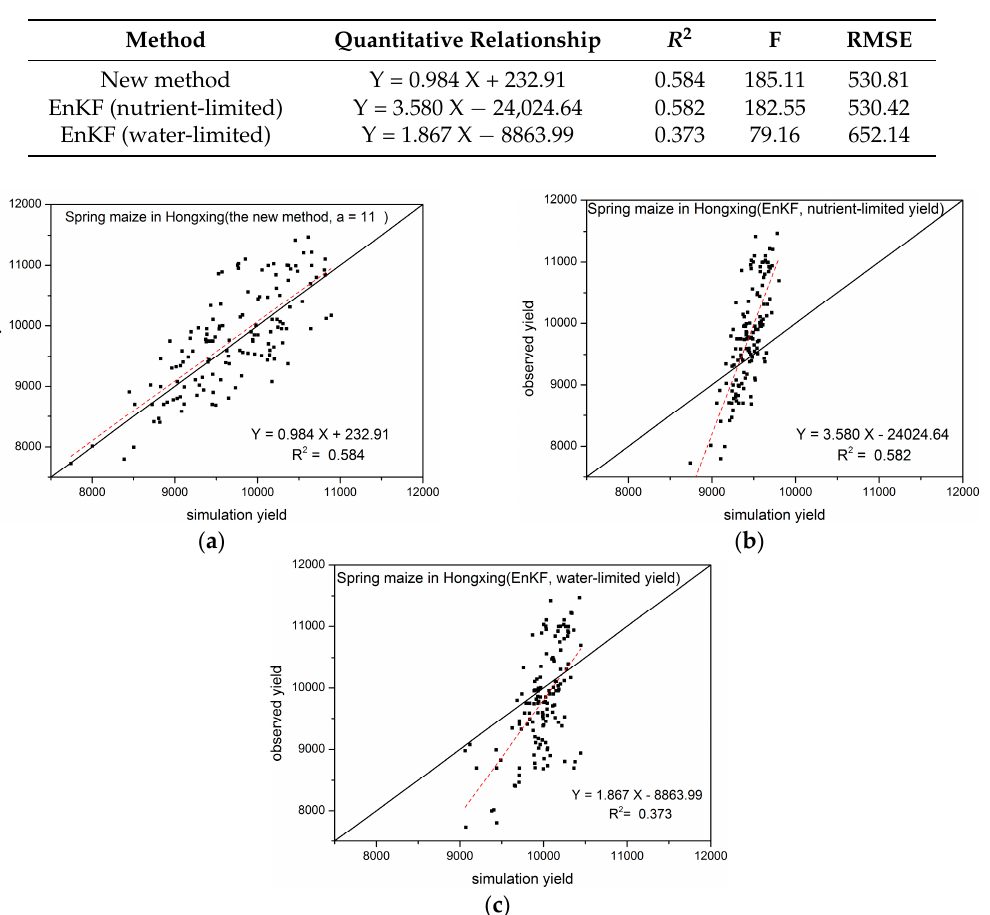
Table 11. Analysis results of the yields of Hongxing in 2014 (kg/ha).